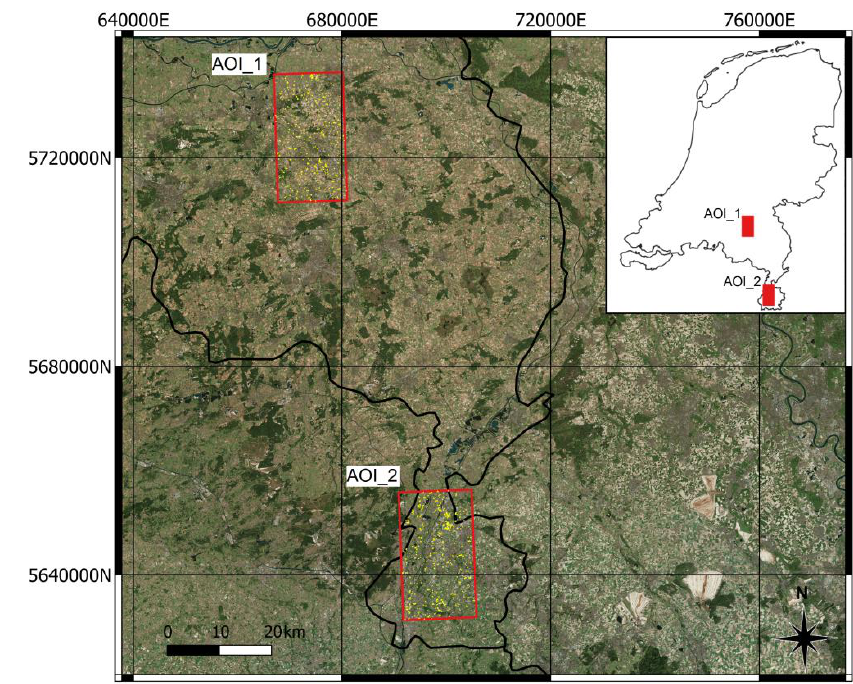
Figure 1. Position of areas of interests (AOIs) in the Netherlands.